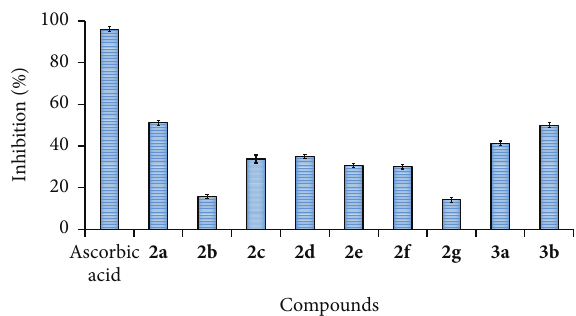
Figure 1: DPPH radical scavenging activity of compounds 2a – 2g and 3a - 3b